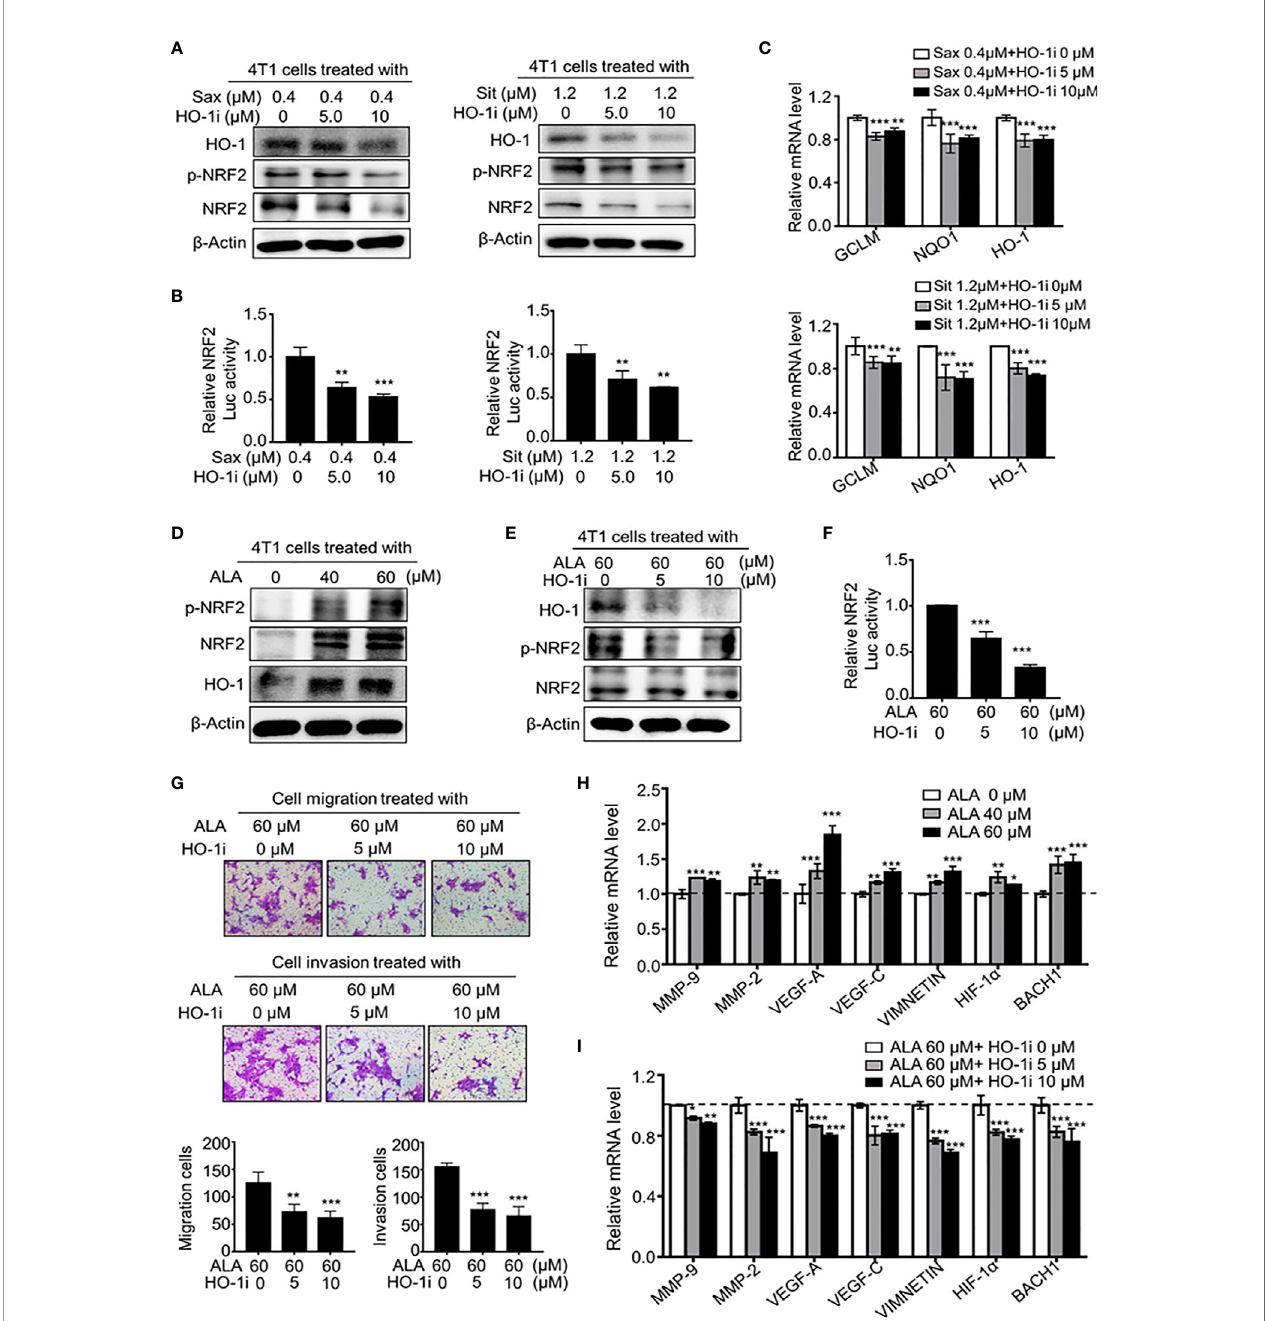
FIGURE 7 | HO-1 reinforces NRF2 activation via a positive feedback loop. (A – C) HO-1 blockage abrogates DPP-4i-driven NRF2 activation in vitro. 4T1 cells were co-treatment with DPP-4i and HO-1 speci fi c inhibitor (HO-1i). HO-1, p-NRF2, and NRF2 expressions were detected by western blotting (A) and NRF2/ARE transcriptional activation was analyzed by luciferase reporter gene assay (B) . NRF2-responsive genes were detected by qRT-PCR (C) . b -Actin gene was as a control. (D) NRF2 activator increases NRF2 activation in 4T1 cells. p-NRF2, NRF2, and HO-1 expressions in ALA-treated 4T1 cells were detected by Western blotting. b -actin was as a loading control. (E, F) HO-1 blockage abrogates ALA-induced NRF2 activation. 4T1 cells were co-treated with or without ALA and HO-1 inhibitor. HO-1, p-NRF2 and NRF2 expressions were analyzed by Western blotting (E) . NRF2/ARE transcriptional activation was detected by luciferase reporter gene assay (F) . (G) HO-1 inhibition attenuates ALA-induced BC migration and cell invasion. 4T1 cells were co-treated with ALA and HO-1 inhibitor. Cell migration and cell invasion assays were performed and migration or invasion cells were counted in 5 to 10 random fi elds. (H, I) HO-1 blockage abrogates ALA-driven metastasis- associated gene levels. 4T1 cells were treated with ALA alone (H) or were co-treated with ALA and HO-1 inhibitor for 4h (I) . Metastasis-associated gene levels were detected by qRT-PCR. b -actin gene was as an internal control. Representative images are shown. Data are presented as mean ± SD of three independent experiments. Scale bar: 50 m m. *p<0.05, **p<0.01, and ***p<0.001 between the indicated groups determined by one-way analysis of variance